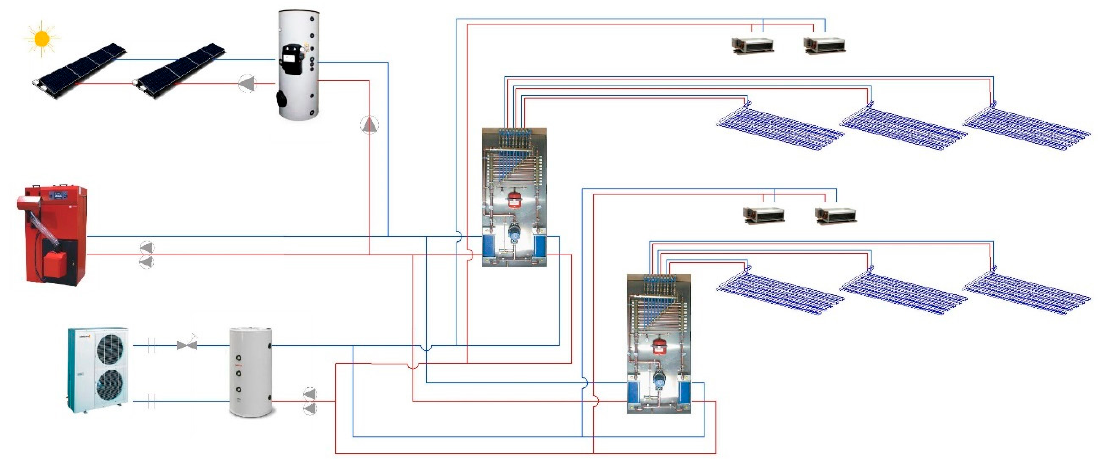
Figure 5. The circuit installation diagram based on three tubes with substations.